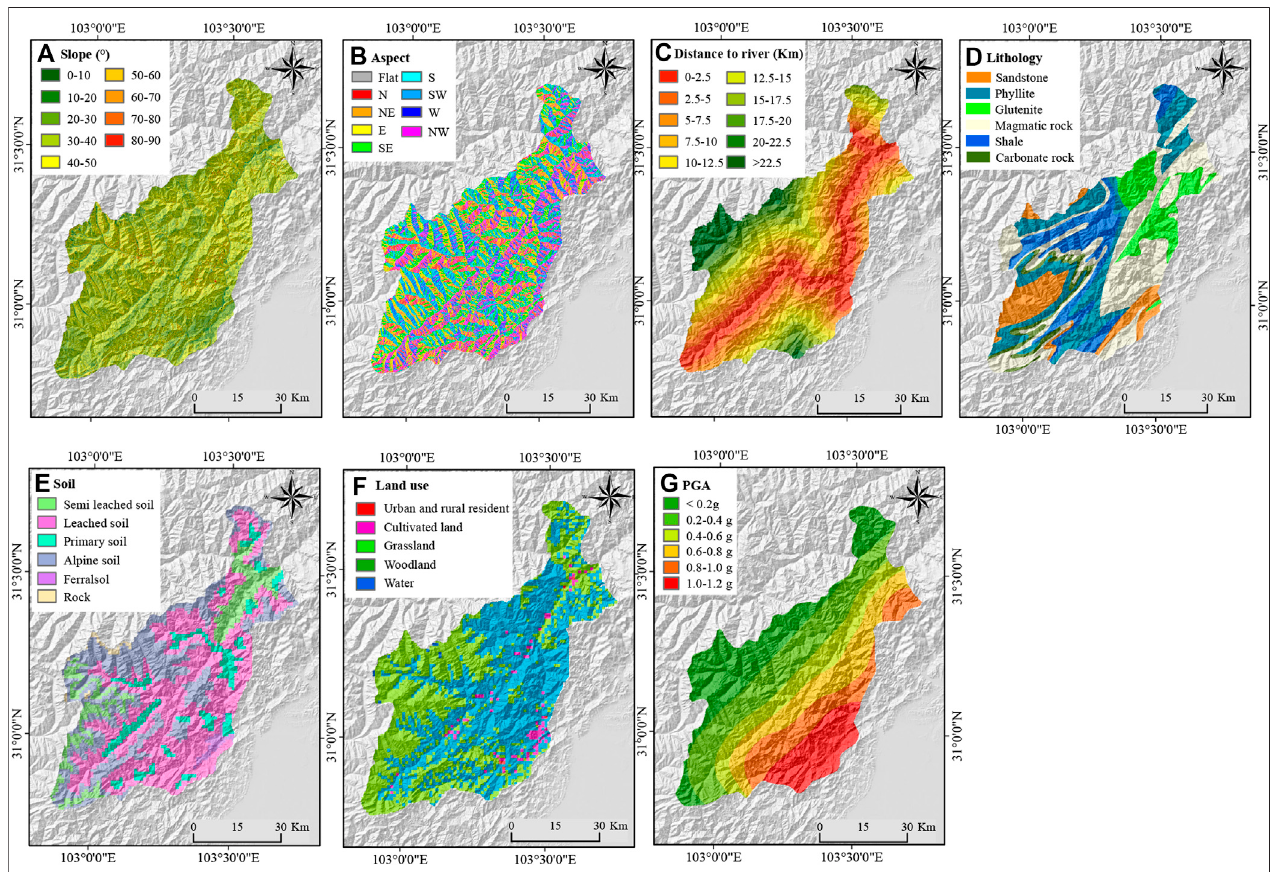
FIGURE 5 | The landslide causative factors used in this study. (A) Slope, (B) Aspect, (C) Distance to river, (D) Lithology, (E) Soil, (F) Land use, (G) PGA.